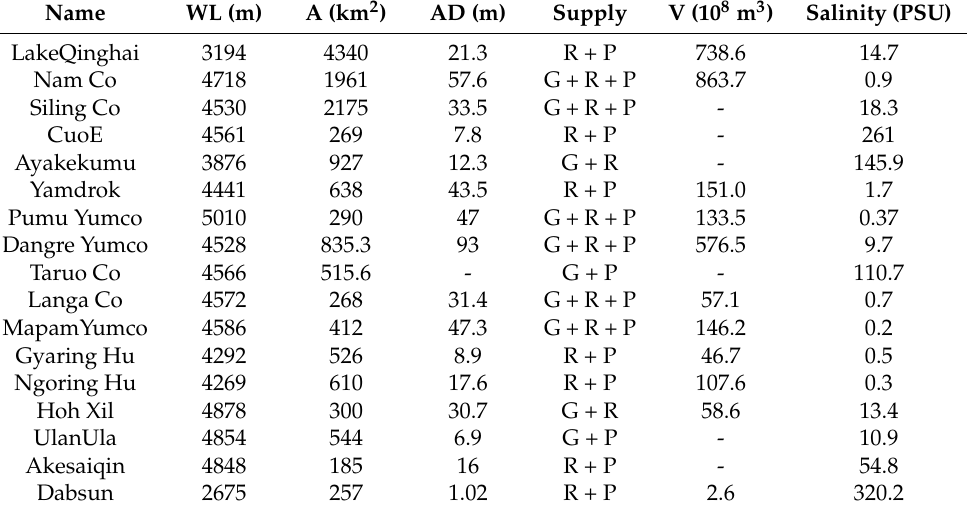
Table 1. Limnological characteristics of typical lakes across the Tibetan Plateau for water surface temperature